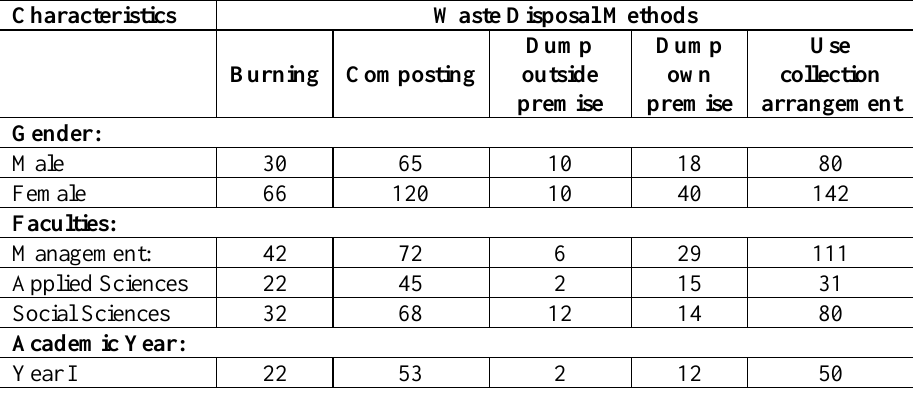
Table 05: Comparison of Waste Disposal Methods and Demographic Characteristics (number of students in count)